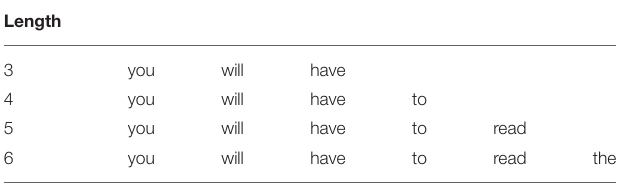
TABLE 1 | Example of expanding lexical bundle in Hawkes.